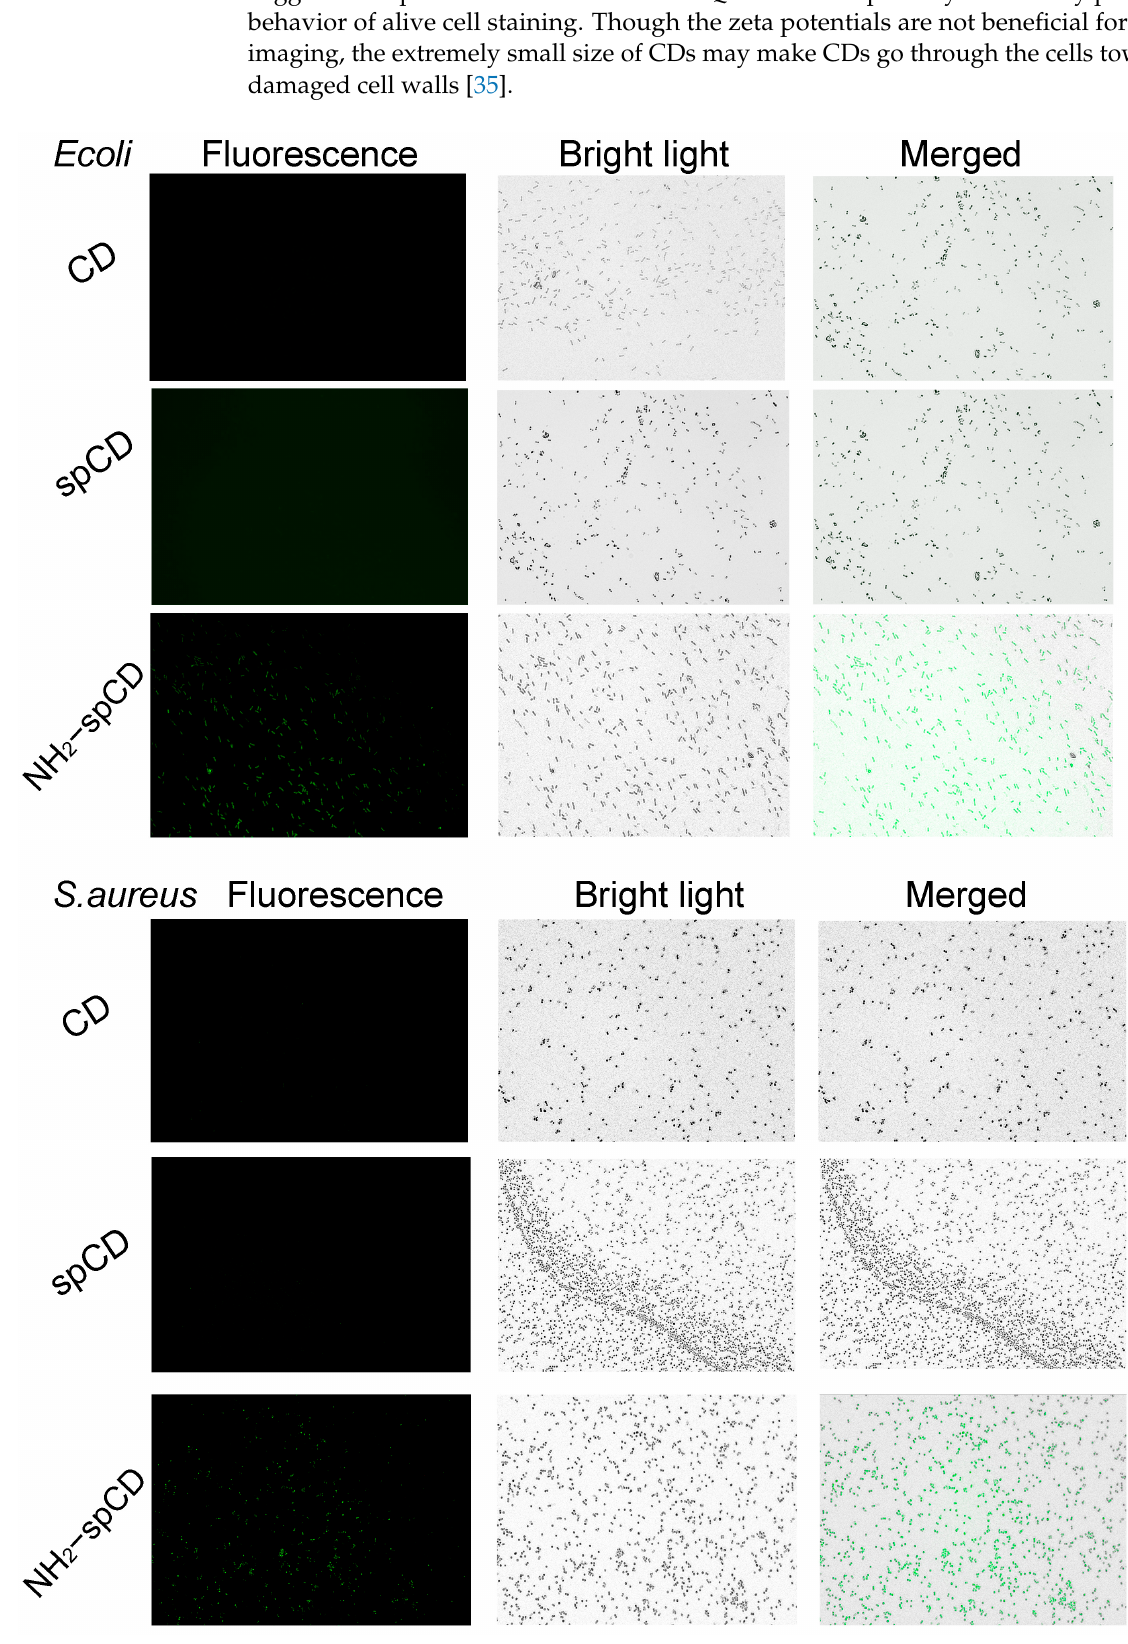
Figure 6. Imaging of alive E.coli and S.aureus by CD, spCD and NH 2